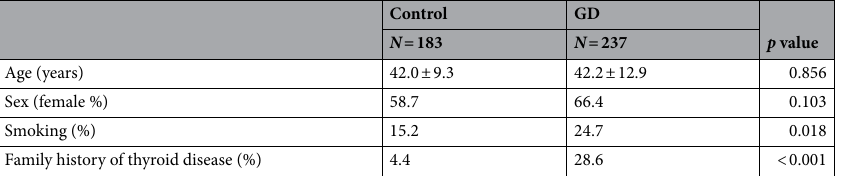
Table 1. Demographic characteristics of Graves’ disease (GD) patients and a healthy control group at the time of sample collection. p < 0.05 indicates statistical